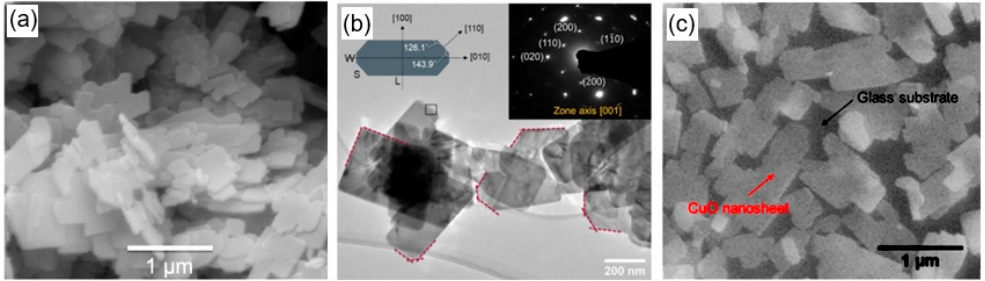
Figure 46. Cross-sectional TEM images of the 10-layer film of Ti 0.87 O 2 nanosheets formed using the LB deposition technique: ( a ) Wide view; ( b ) magnified image. Reproduced with permission from Akatsuka et al. [405]. Copyright 2009: American Chemical Society. Figure 47 . ( a ) SEM images of as-synthesized CuO nanosheets; ( b ) low-magnification TEM image of CuO nanosheets and the SAED pattern and a sketch of the crystal orientation in the real space as inset; ( c ) top surface SEM image of the CuO nanosheet monolayer on the glass substrate. Reproduced from Miao et al. [406]. Published by ACS as open access.